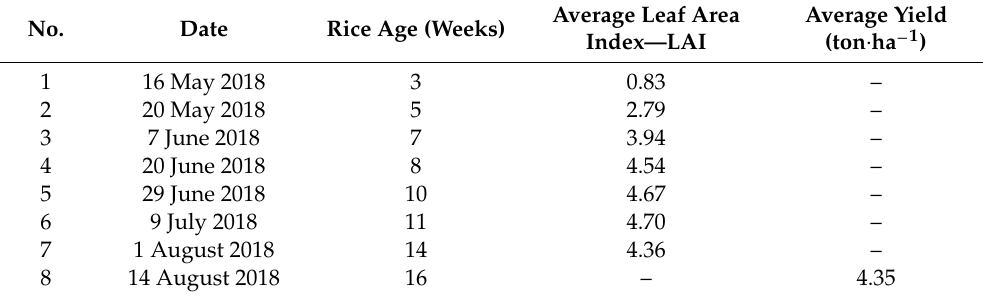
Figure 5. Relative spectral responses of a Parrot Sequoia camera (Green, Red, Red Edge and NIR), as well as the most closely corresponding Sentinel–2A bands (bands 3, 4, 6 and 7) (excerpted from [18]).